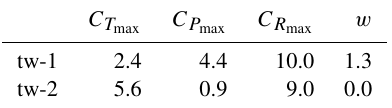
Table 2. Correction coefficients for temperature ( C T ( C P ), rainfall ( C R ) and epicentral distance ( w ) maximizing max max the cross-correlation function (CC) in time windows tw-1 (Jan- C T